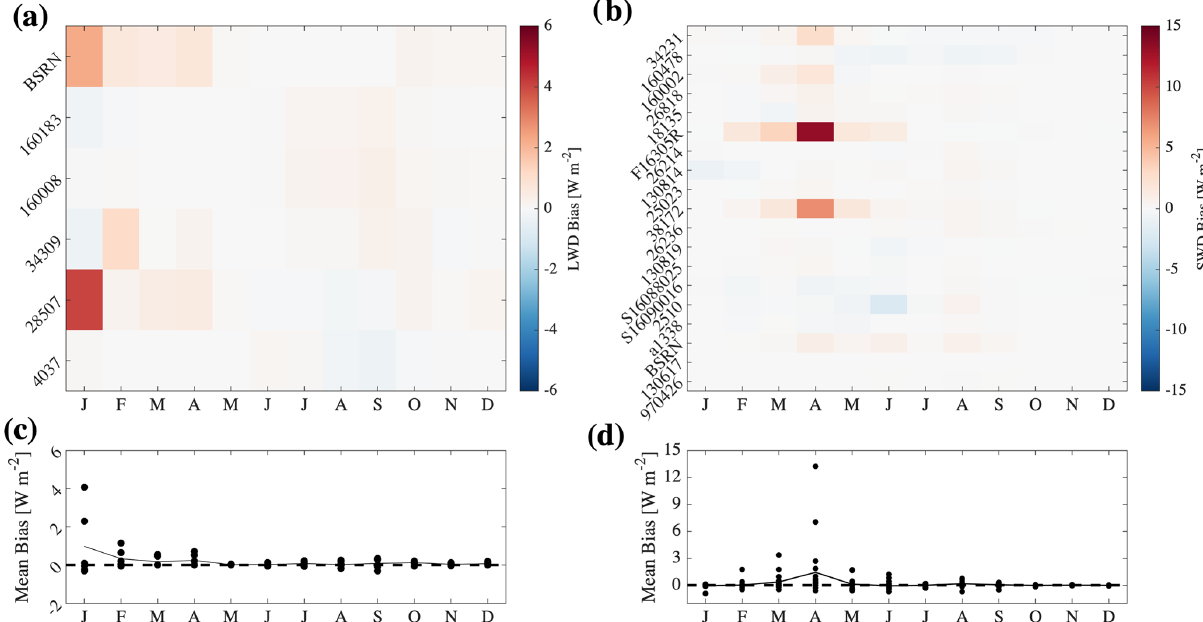
Figure 6. Calculations of biases in monthly means relative to the BE for LWD (a, c) and SWD (b, d) . (a, b) show individual instruments and months; the same data are plotted in time series form in the (c, d) for reference. All calculations are corrected for statistical differences between individual radiometers and the BE when ice-free. The calculations are for all conditions, not just times when ice was